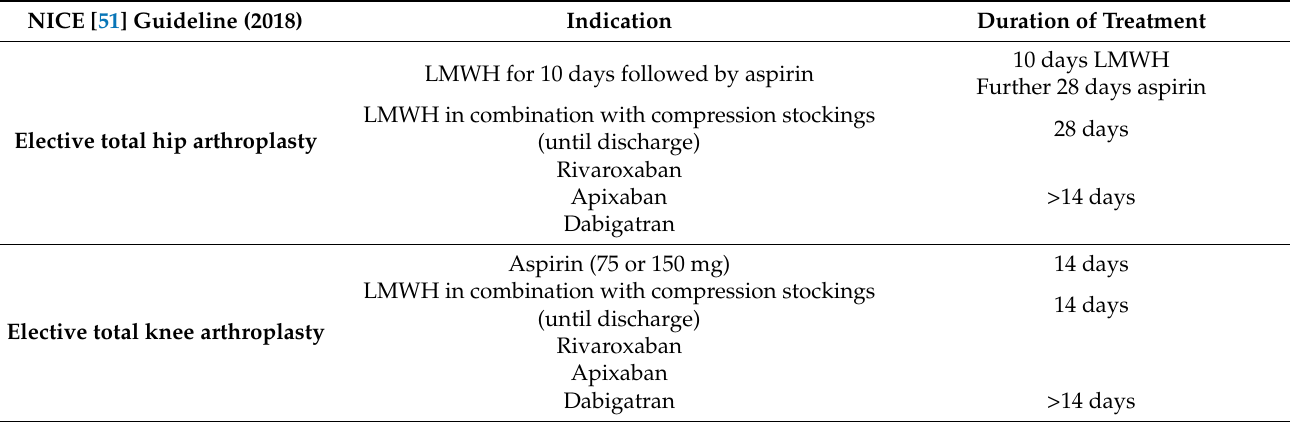
Table 5. NICE [51] Guideline Recommendations for VTE Prophylaxis in Orthopaedic